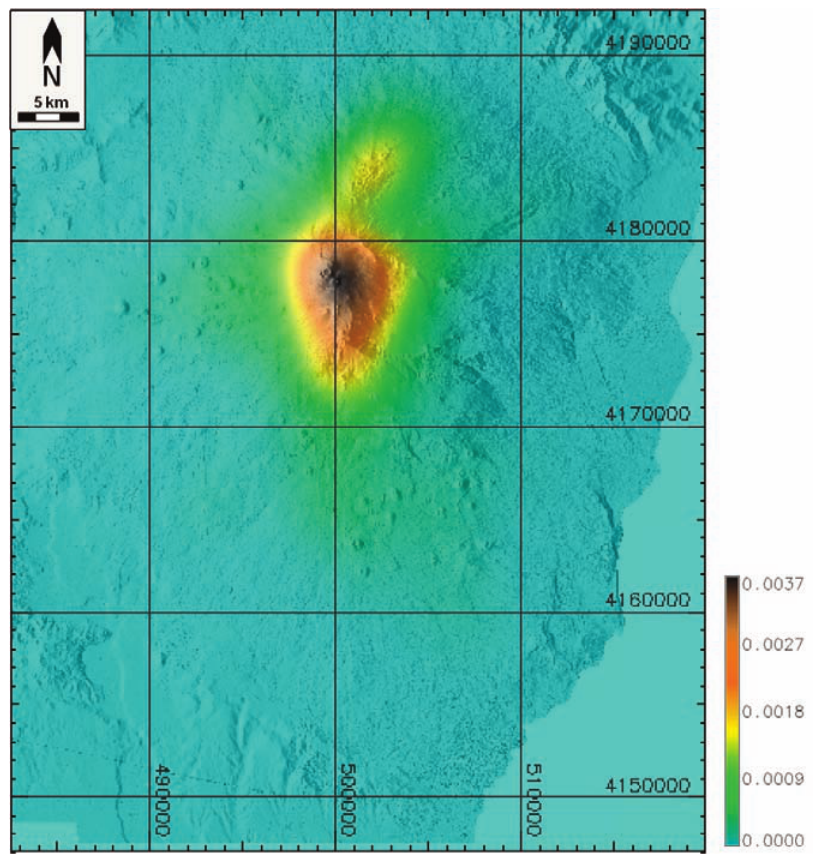
Figure 1. Susceptibility map at Mount Etna, as updated using dikes, faults and eruptive fractures until 1981. The colors are associated with different levels of vent opening probability.